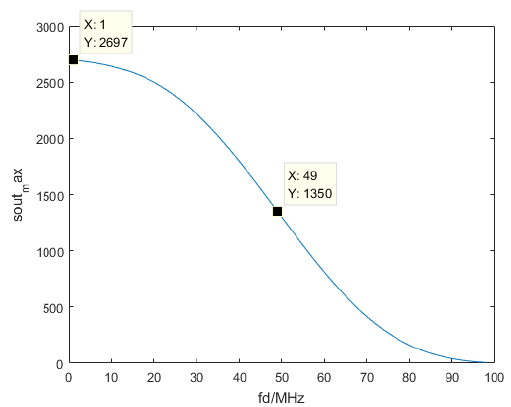
Figure 9 . The effect of frequency mismatch. Figure 9. The e ff ect of frequency